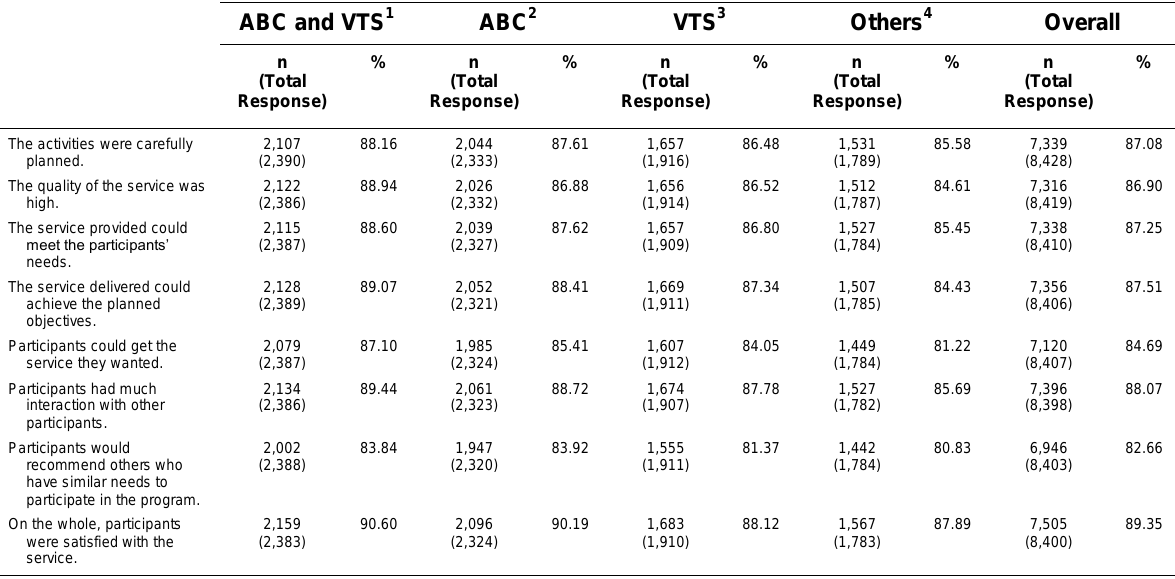
Comparison of the Positive Views towards the Tier 2 Program among Different Program Approaches Participants with Positive Responses in Different Program Approaches